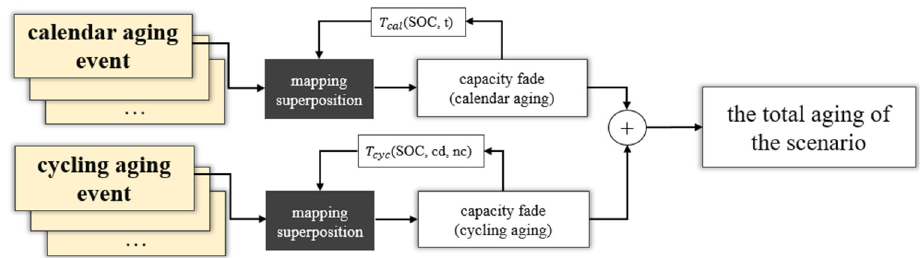
Figure 11. A schematic diagram for superposition.